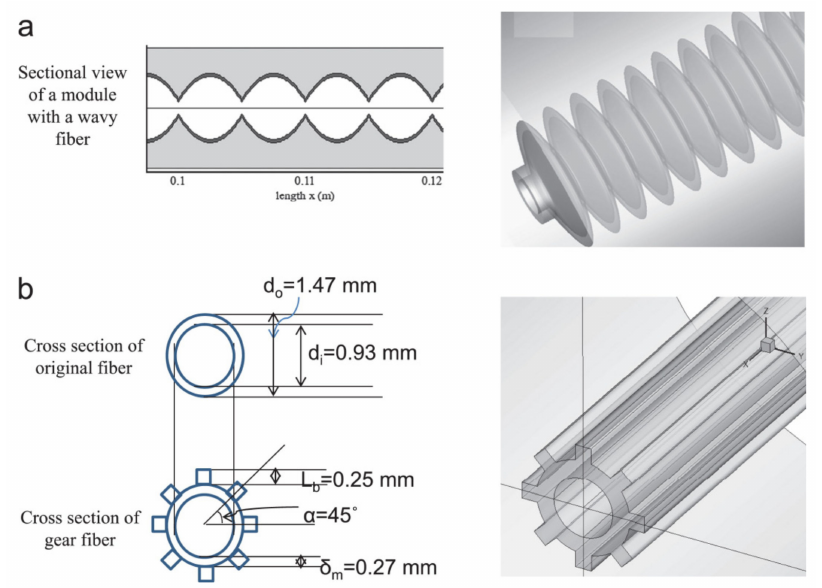
Figure 20. 3D geometric structures of modules with ( a ) wavy fiber and ( b ) gear-shaped fiber [56]. Reproduced with permission from Elsevier,